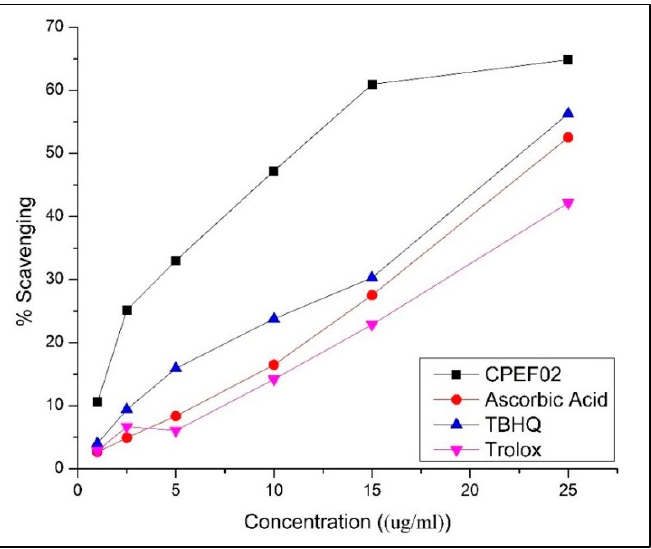
Figure 5. Antioxidant activity of methanolic CPEF02 extract and standards (ascorbic acid, TBHQ and trolox) against the ABTS radical.